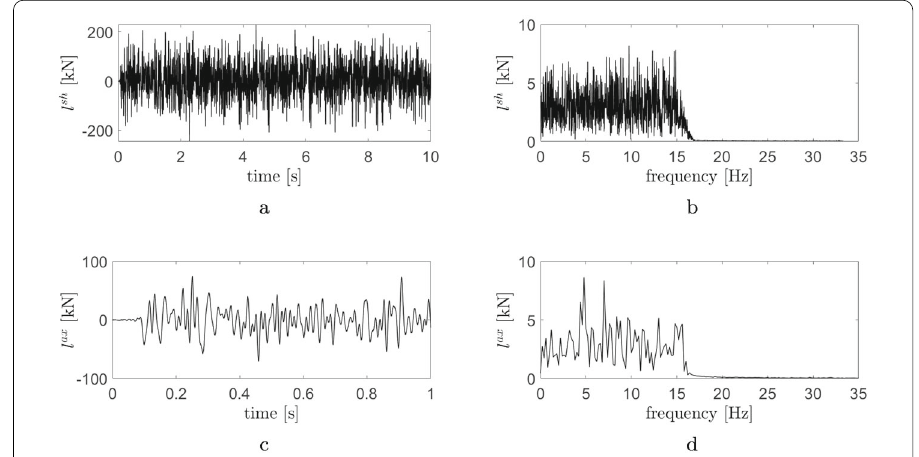
Fig. 11 White noise load case, f min = 15 and f max = 17 Hz. Time evolutions (left column) and Power Spectral Density (right column) of the forces applied to all the building stories in x (first row) and z direction (second row)